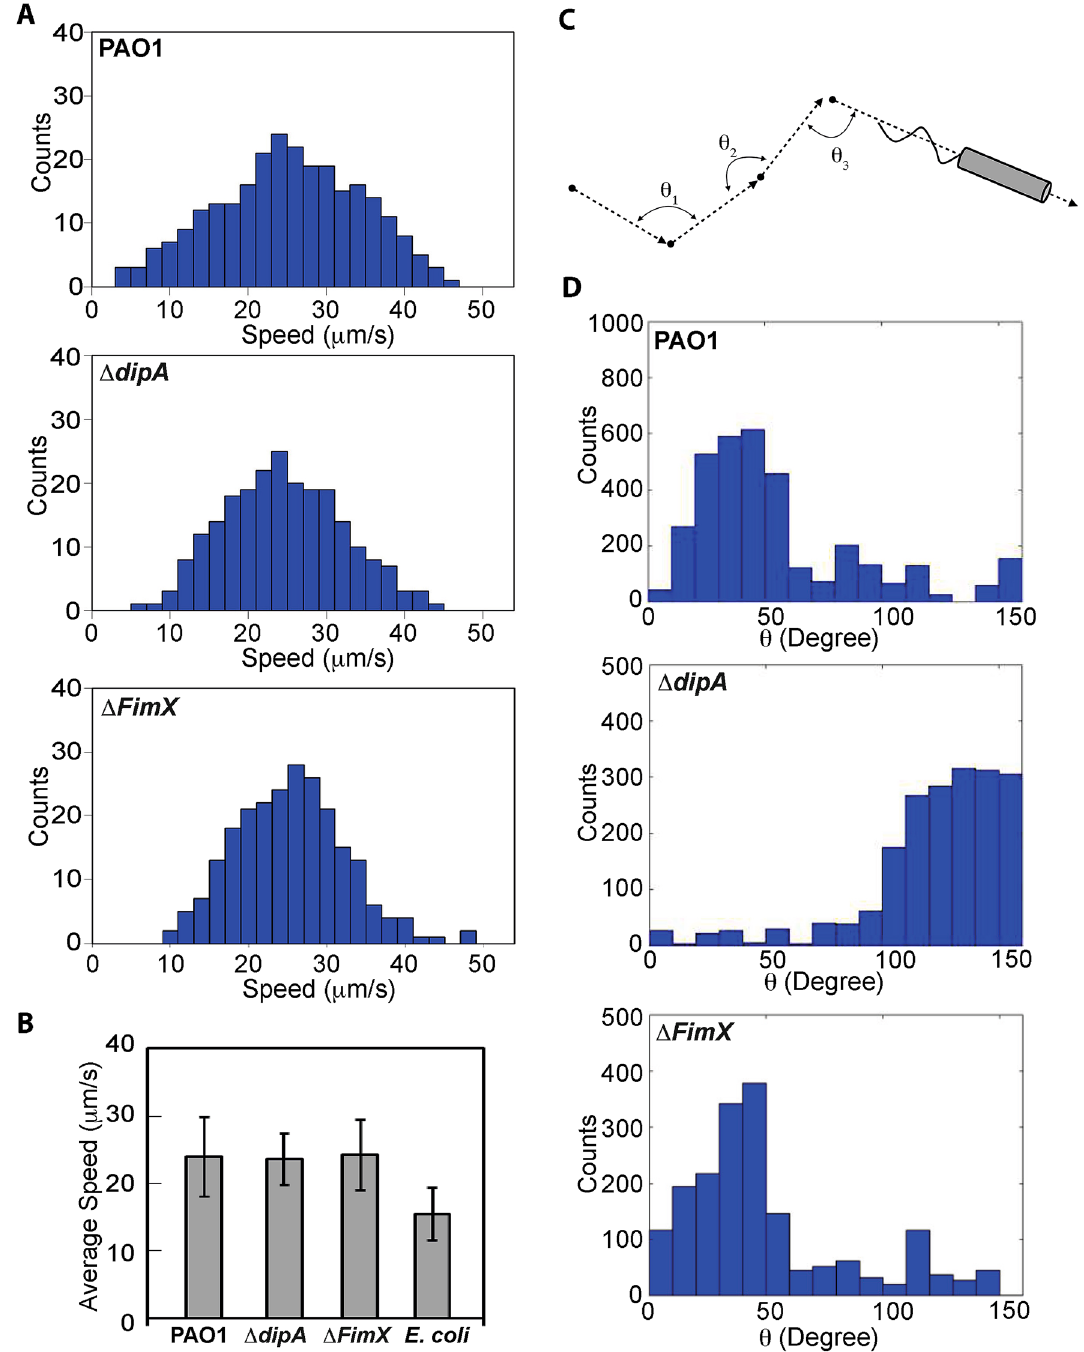
Figure 2. Swimming behavior of PAO1, ΔdipA and ΔFimX . ( A ) Histograms of the speed of PAO1 , ΔdipA and ΔfimX obtained from 323, 598, and 375 cell trajectories tracked from 5 different experiments, respectively. ( B ) Average speeds for PAO1 , ΔdipA, ΔFimX and E. coli are 23.9 ± 6.0 µm/s, 23.6 ± 3.9 µm/s, 24.2 ± 5.0 µm/s, and 15.5 ± 3.9 µm/s, respectively. ( C ) Turning angles for PAO1, ΔdipA, ΔfimX and E. coli . The turning angle, θ, represents the angle between stitched line segments between two adjacent frames. It is the angle between two straight lines, e.g., θ 1 is the angle through two-point locations of the same tracked particle in frames i and i + 1. ( D ) The distribution of turn angles θ during a swimming trajectory was quantified and analysed for PAO1 and ΔfimX and ΔdipA